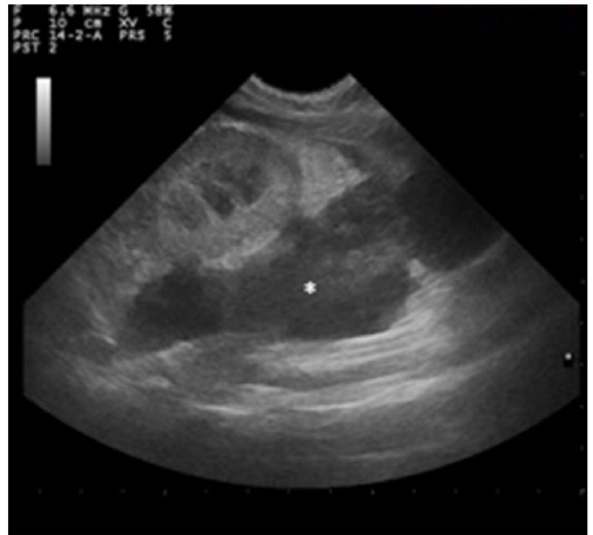
Figure 4. Ultrasound examination of left kidney showing anechogenic area in the left hemiabdomen (asterisk) containing small areas of echogenic tissue attributable to intraperitoneal fat. Positive contrast radiographs in the lateral and ventrodorsal projections immediately after the injection of the contrast agent allowed for defining the extent of the lesion, outlining the fluid collection as a large well-marginated homogeneous radiopaque area in the left retroperitoneal space and differentiating it from ascite (Figure 5A,B).